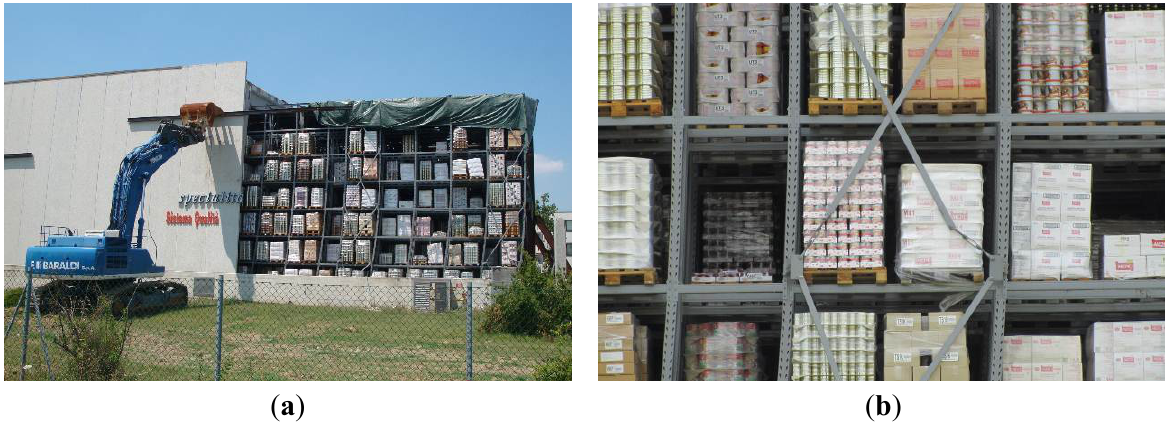
Figure 6. Storage building with internal braced steel scaffolding system: ( a ) Global view; ( b ) Failed connection of steel